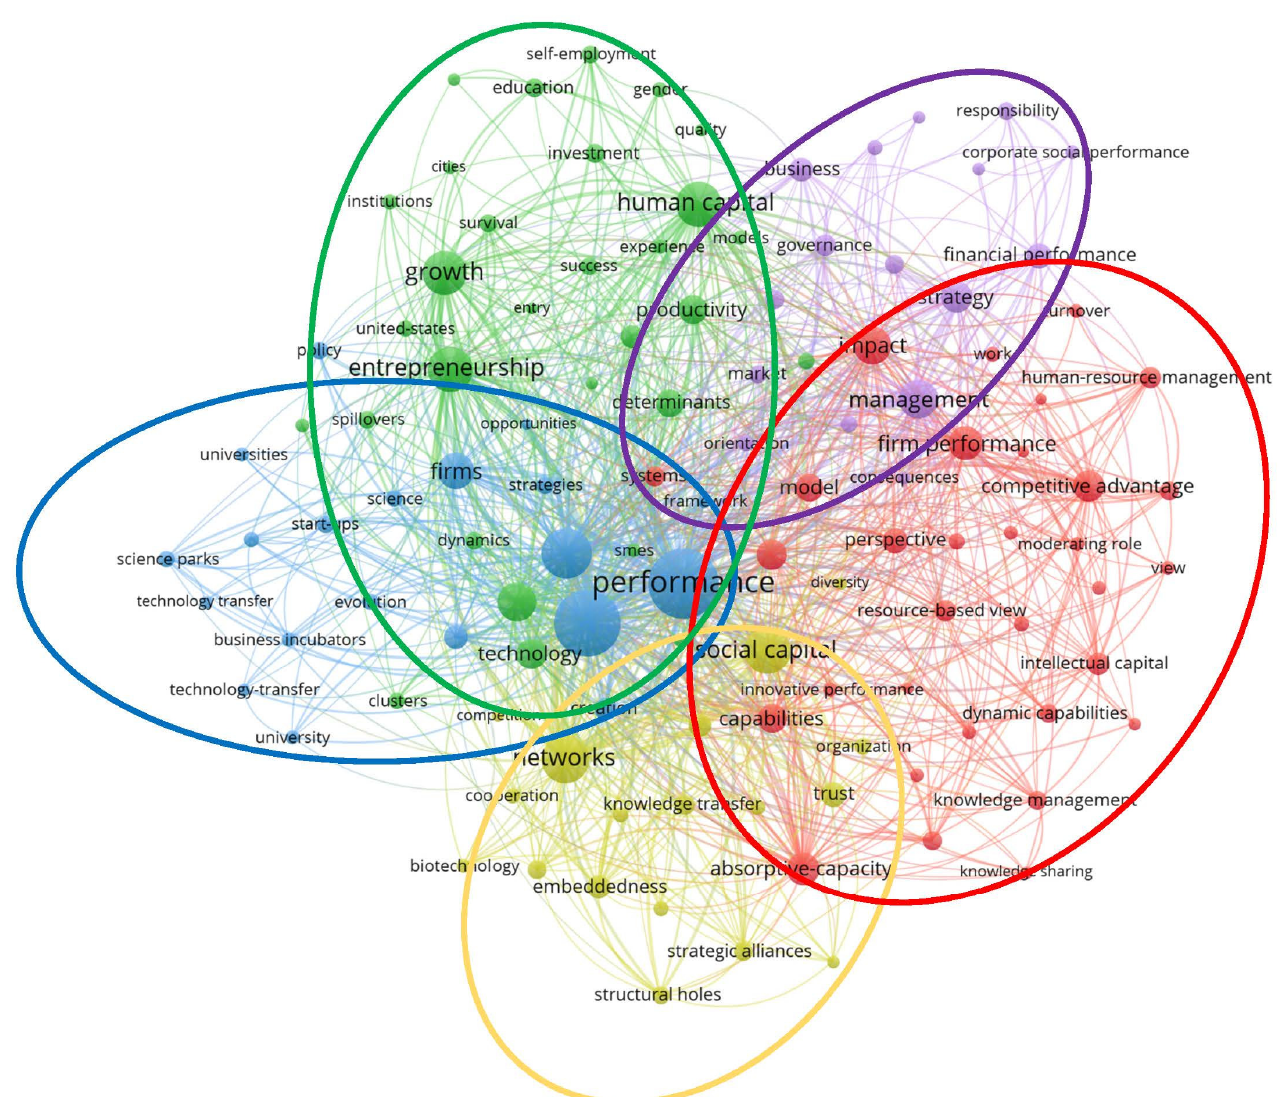
Figure 8. Word co-occurrence (Source: Own elaboration using the VOSviewer software).